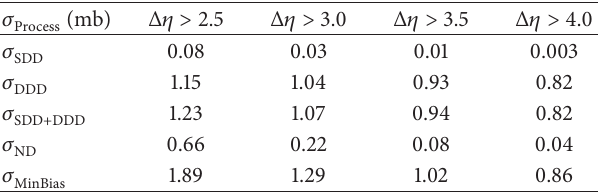
Table 4: Visible cross sections for different Δ𝜂 cuts. A cut of 𝑝 T > 200 MeV is applied for all final state particles in |𝜂| < 5.2 and the gap is defined as central